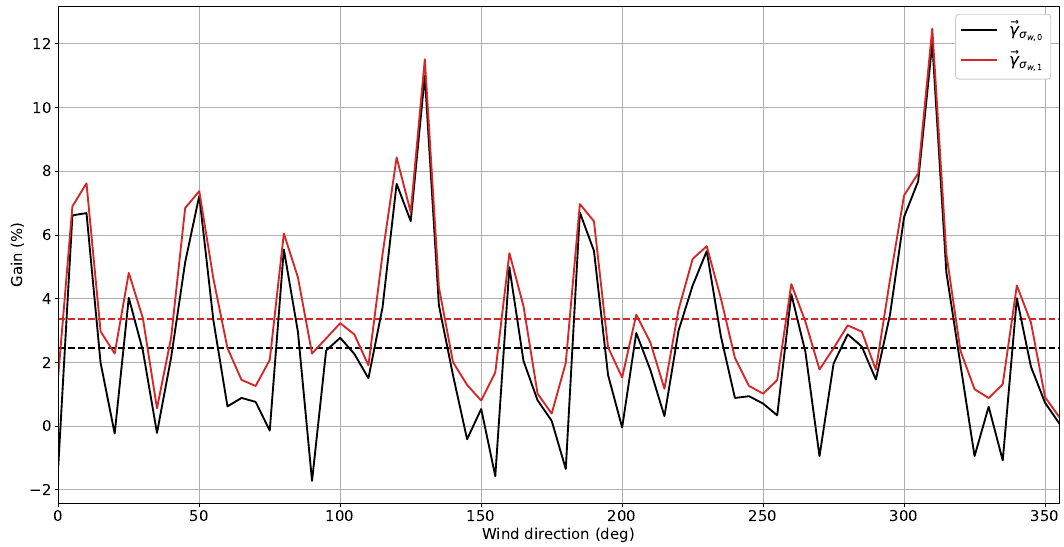
Figure 11. The energy gain per wind direction for (cid:126) γ σ mean gains.